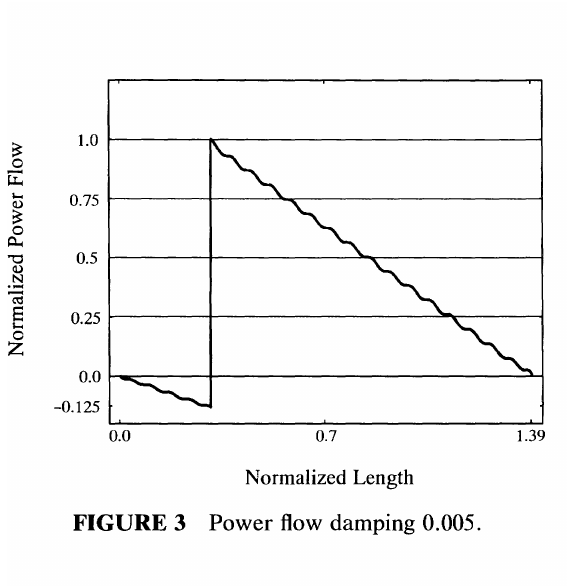
FIGURE 3 Power flow damping 0.005.